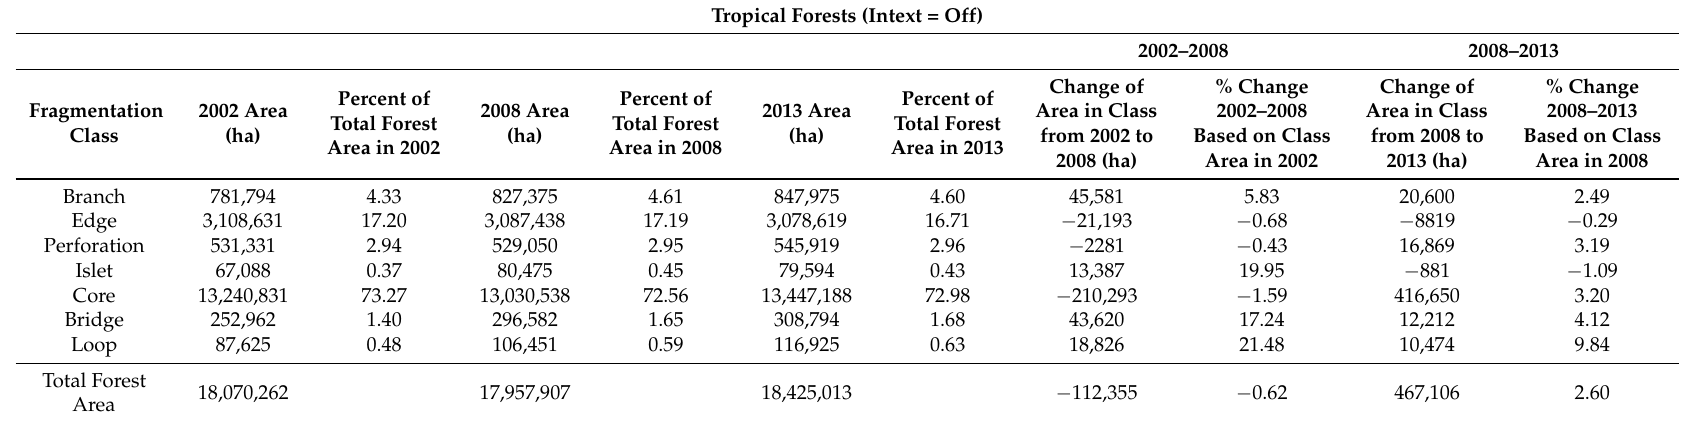
Table 2. Areas in each fragmentation class (intext = “Off”) for the tropical forests in 2002, 2008 and 2013. The differences in area in each fragmentation class and percent changes between dates are presented in the last columns on the right-hand